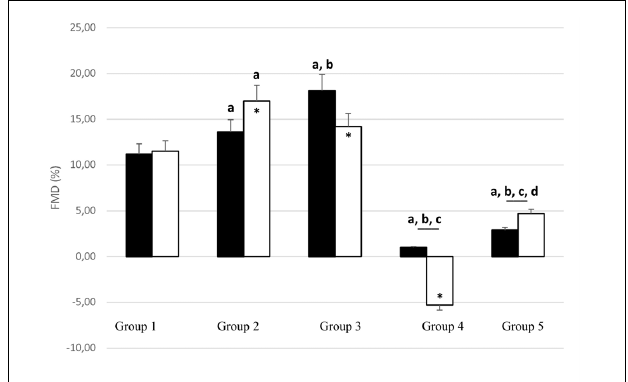
FIGURE 2 | Change in brachial artery diameter with occlusion test [flow-mediated dilation (FMD);% of basal diameter] before (black bars) and after (white bars) PWC 170 . Data are presented as the mean ± error of the mean. a , b , c , d Significantly different ( p < 0.05) from Group 1, Group 2, Group 3, Group 4, respectively. ∗ Significantly different from before PWC 170